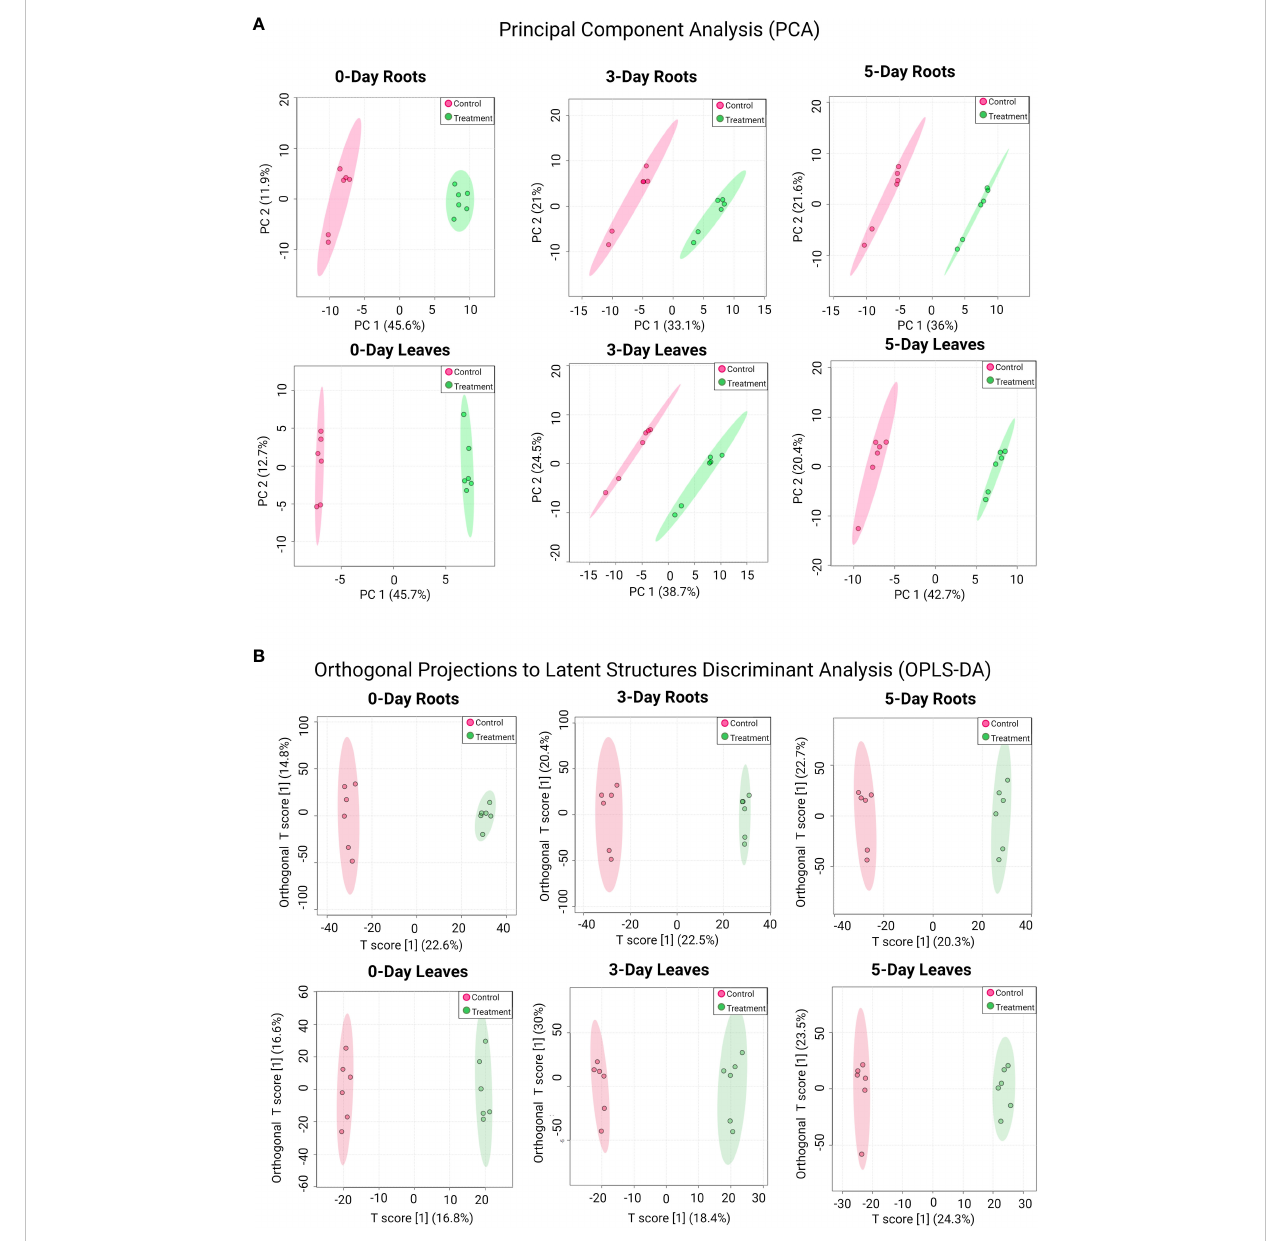
FIGURE 2 PCA (A) and OPLS-DA analysis (B) for detected compounds in SWE-treated and non-treated roots and leaves across different time points. Data were transformed by log 10 . Different treatment groups are indicated by the color (red color represents control samples and green color represents SWE- treated samples). Data presented are from six replicates with three individual experimental